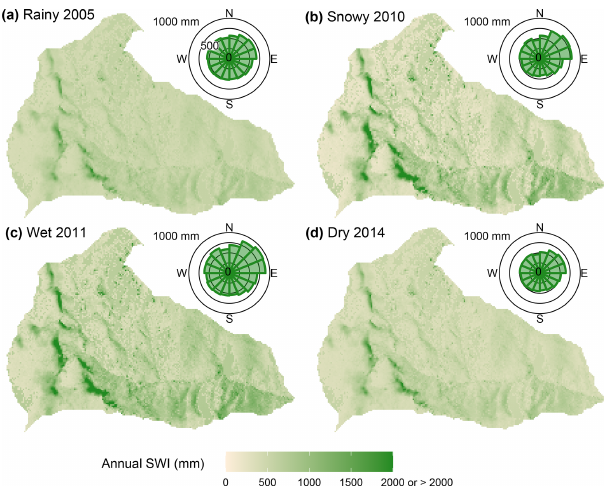
Figure 3. Maps showing the yearly sum of surface water inputs (SWI, mm) for (a) rainy 2005, (b) snowy 2010, (c) wet 2011, and (d) dry 2014, with polar diagram insets showing the average sum of SWI per 10m grid cell for each aspect (binned per 22.5 ◦ ). Higher SWI values are shown in darker colors, lower SWI values are shown in lighter colors, and SWI values are capped at 2000mm to enhance the contrast. Maximum annual SWI values are shown in Table 1, and a map of simulated SWI for 2009 is shown in Fig. S13 in the